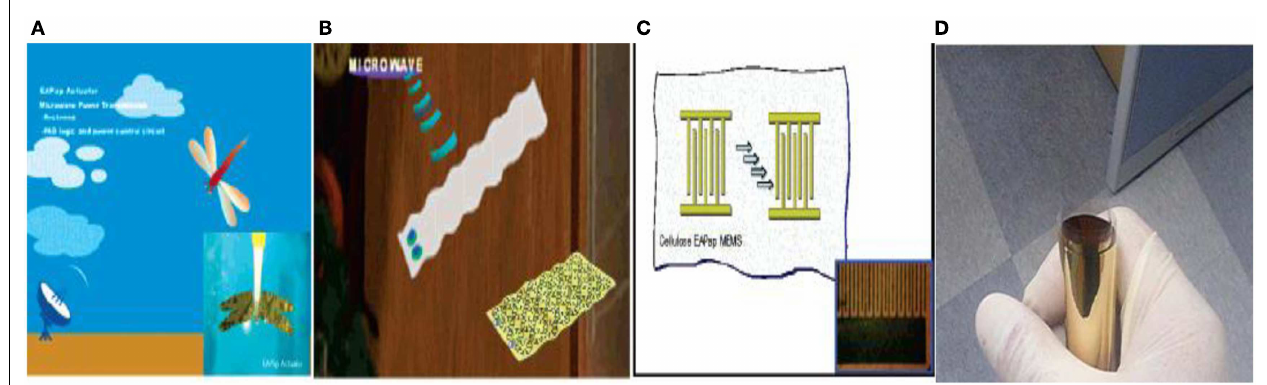
FIGURE 2 | Cellulose paper applications: (A) micro-flying object; (B) micro-insect robots; (C) biodegradable MEMS; (D) thin flexible EAPap speaker film after electrode formation . Adapted with permission from Kim et al. (2006b,